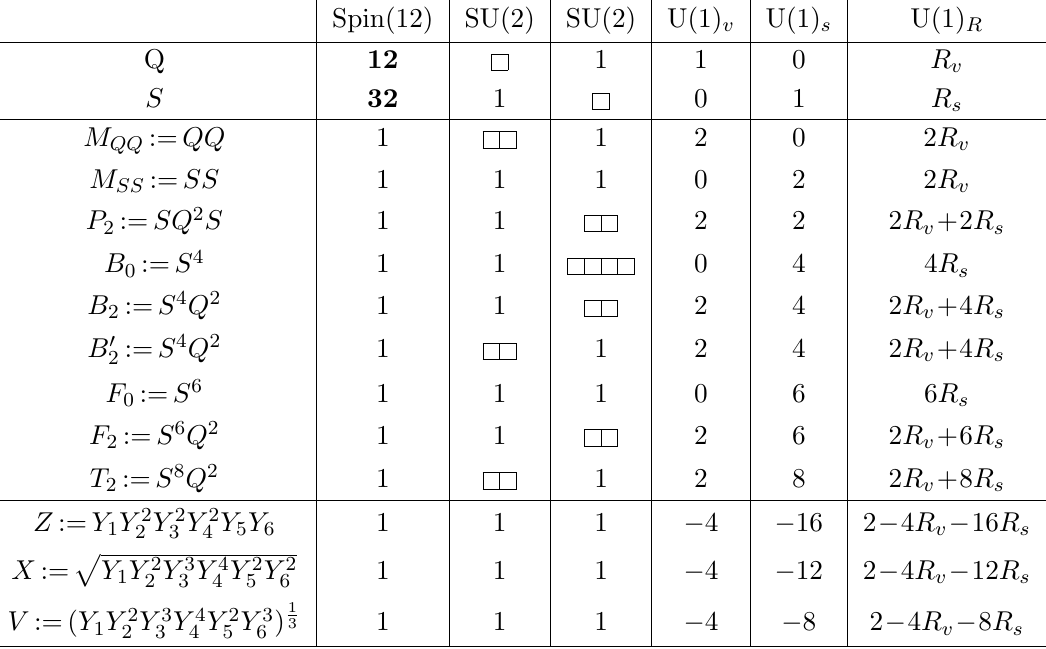
Table 21 . 3d N = 2 Spin(12) theory with ( N v ; N s ; N s 0 ) = (2 ; 2 ;